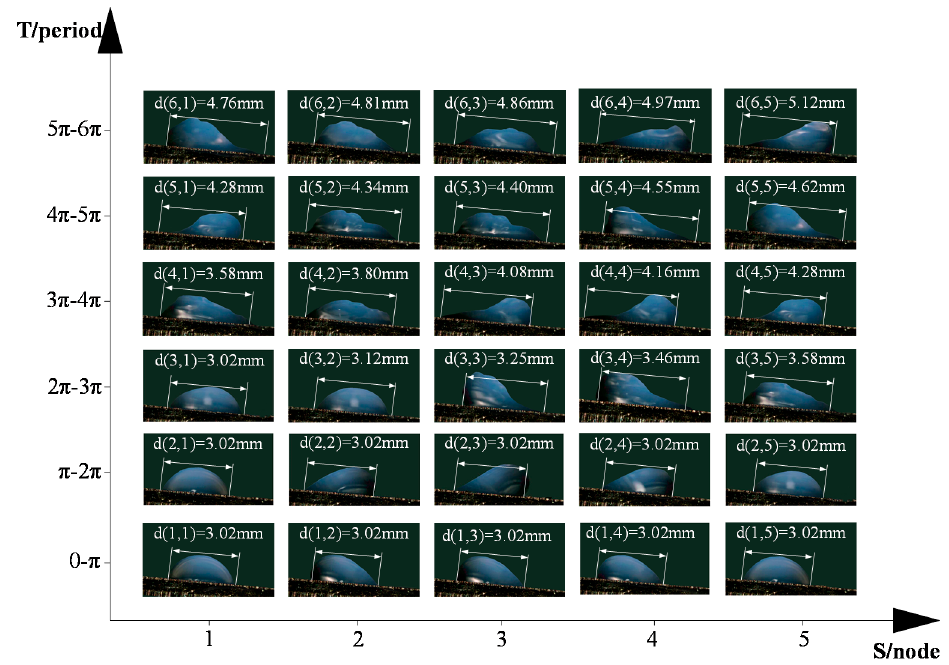
Figure 3. Transient evolution of vibrating drop in three periods on textured surfaces.